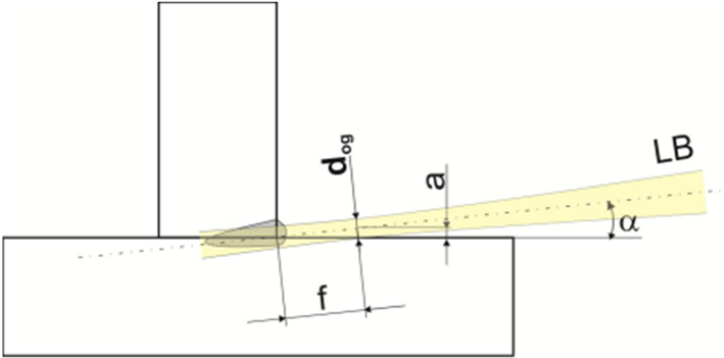
Figure 4. Schematic diagrams of primary geometrical correlations between the position of the laser beam focus having diameter d foc and the interface (line) of the plates in the welded joint area.